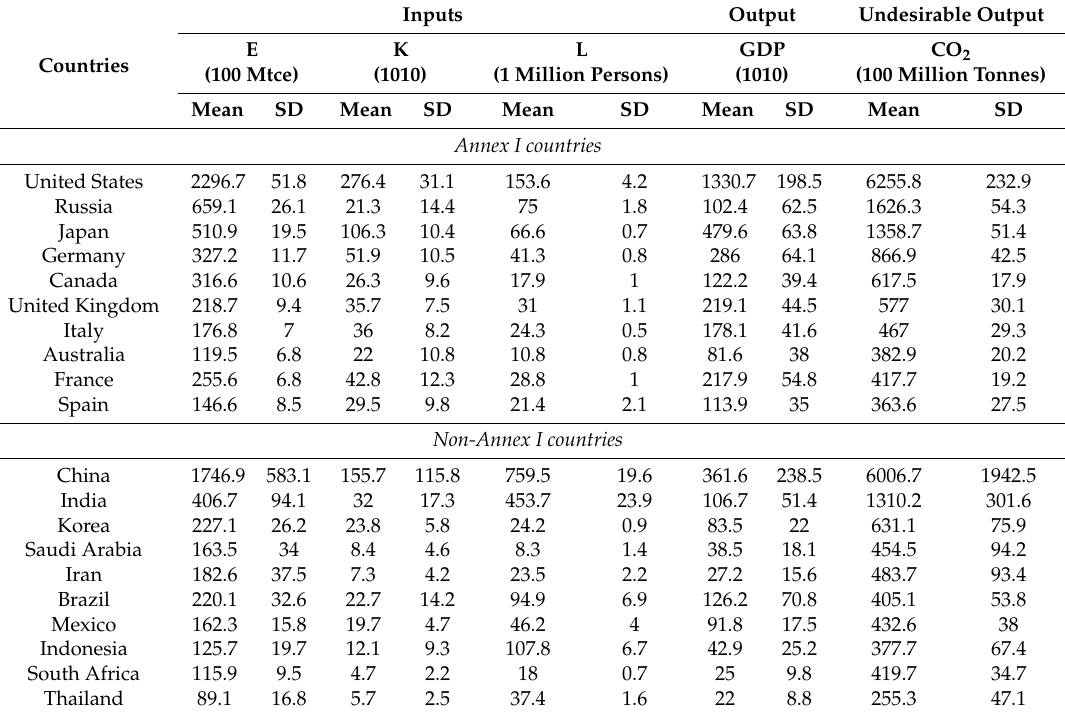
Table 1. Summary statistics of input and output factors by region